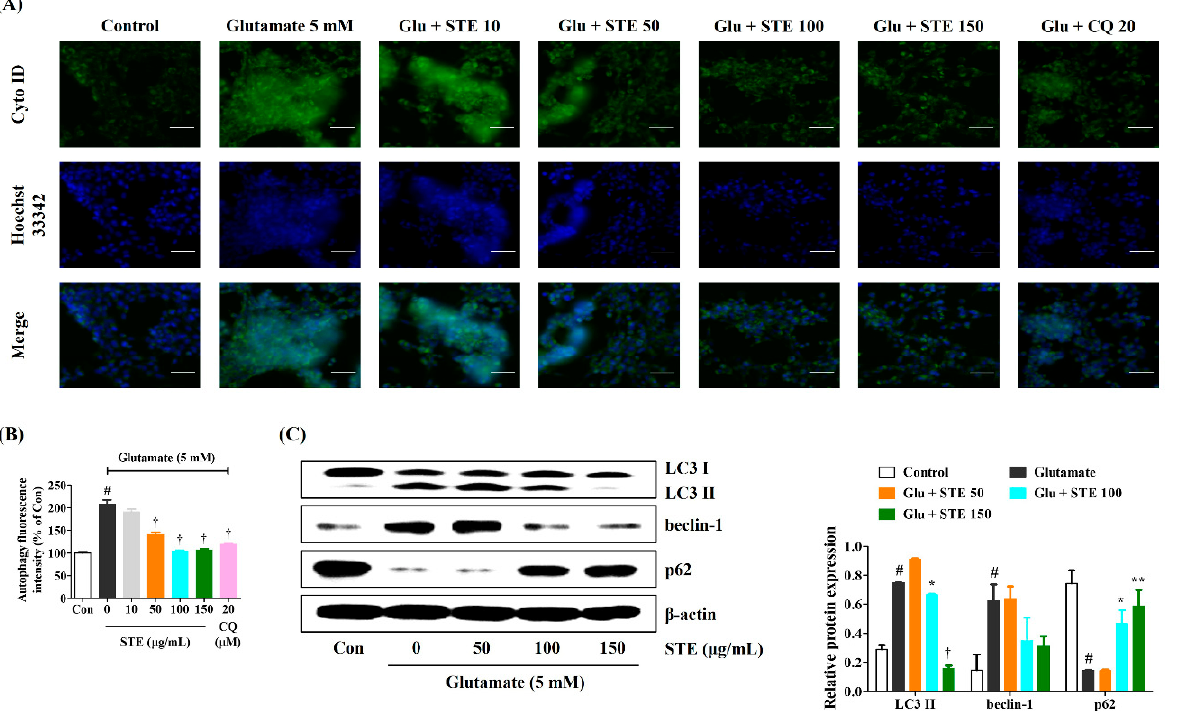
Figure 5. Effects of Selaginella tamariscina ethanol extract (STE) against glutamate-induced autophagy in HT22 cells. Cells were pretreated with STE concentrations of 10, 50, 100, or 150 µ g/mL or 20 µ M chloroquine and then exposed to glutamate (5 mM). ( A ) The autophagy level of HT22 cells was evaluated using Cyto-ID ® green autophagy dye and analyzed by fluorescence microscopy. Images represent three independent experiments at a magnification of 200 × . Scale bar = 100 µ m. ( B ) Autophagy fluorescence intensity level was determined using Image J software. ( C ) The expression levels of light chain 3 II, Beclin-1, and p62 were determined via Western blot analysis. Control cells were incubated with the vehicle alone. Blot images were representative of the three independent experiments. Data are presented as mean ± standard error of the mean. Glu, glutamate; CQ, chloro- quine; Con, control; LC, light chain. Statistical significance was defined as # p < 0.05 (vs. control), * p < 0.05, ** p < 0.01, and † p < 0.001 (vs. glutamate).